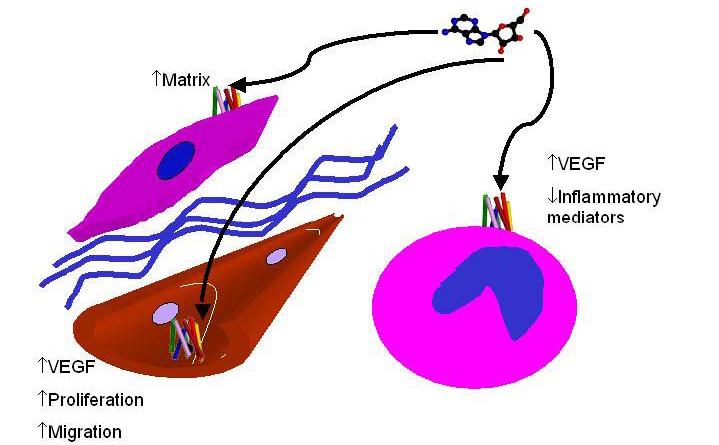
FIGURE. The effect of adenosine, acting at A 2A receptors, on the cells involved in wound healing. VEGF: vascular endothelial cell growth